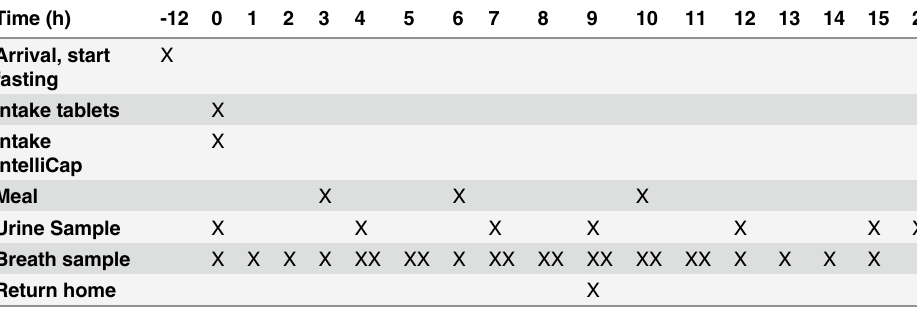
Table 3. Study schedule, activities are marked with an X (T0 is 8